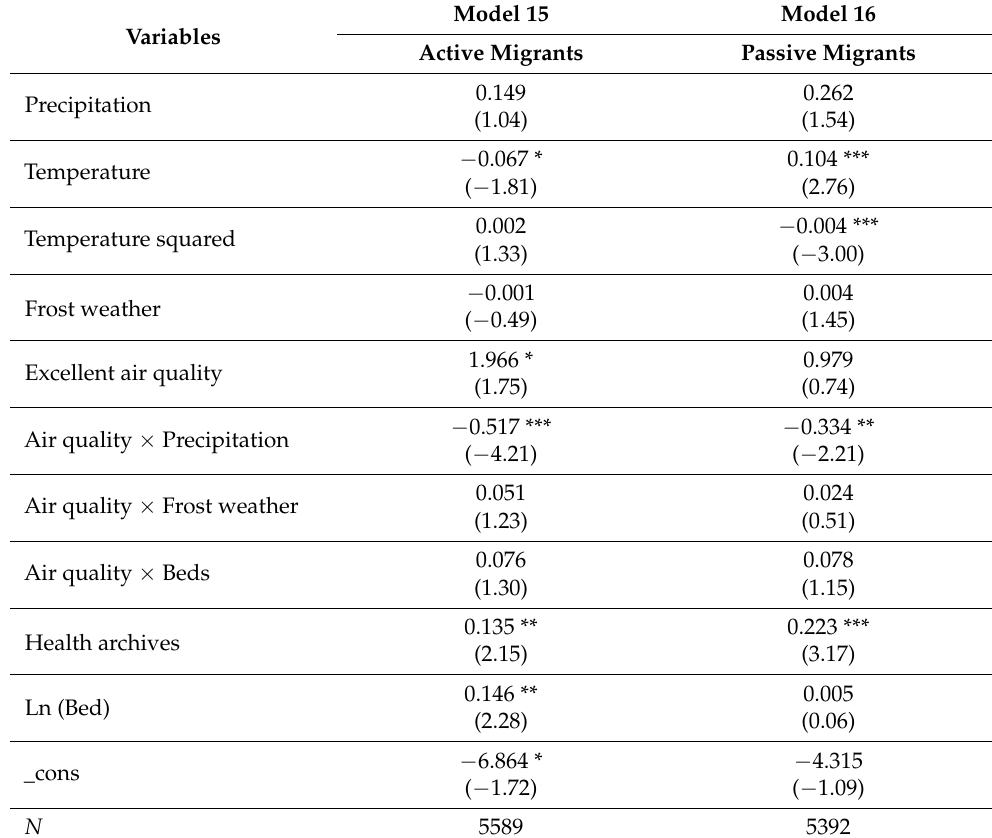
Table 7. The natural amenity and elderly migrants’ settlement by migration